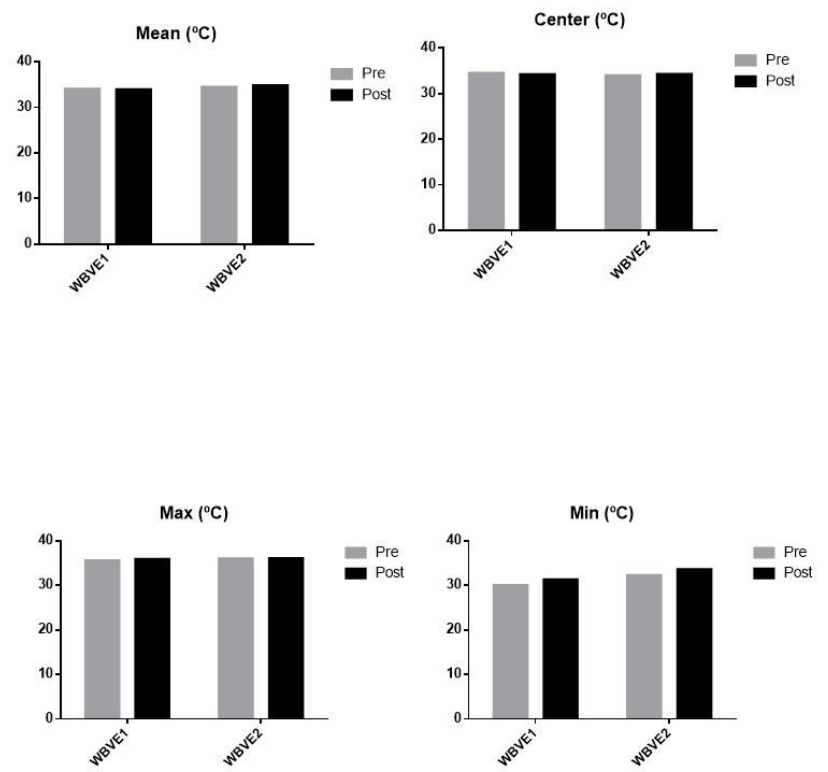
Figure 1. WBVE results of the anterior region of the neck assessed by infrared thermography. WBVE 1 = whole-body vibration exercise sitting on the auxiliary chair; WBVE 2 = whole-body vibration exercise sitting directly on the base of the platform; Max = maximum temperature; Min = minimum temperature. It is possible to verify that the maximum and minimum temperatures, as well as the mean temperature, were slightly increased post WBVE 1 compared to pre WBVE 1. Pre and post the WBVE 2, the center temperature remained